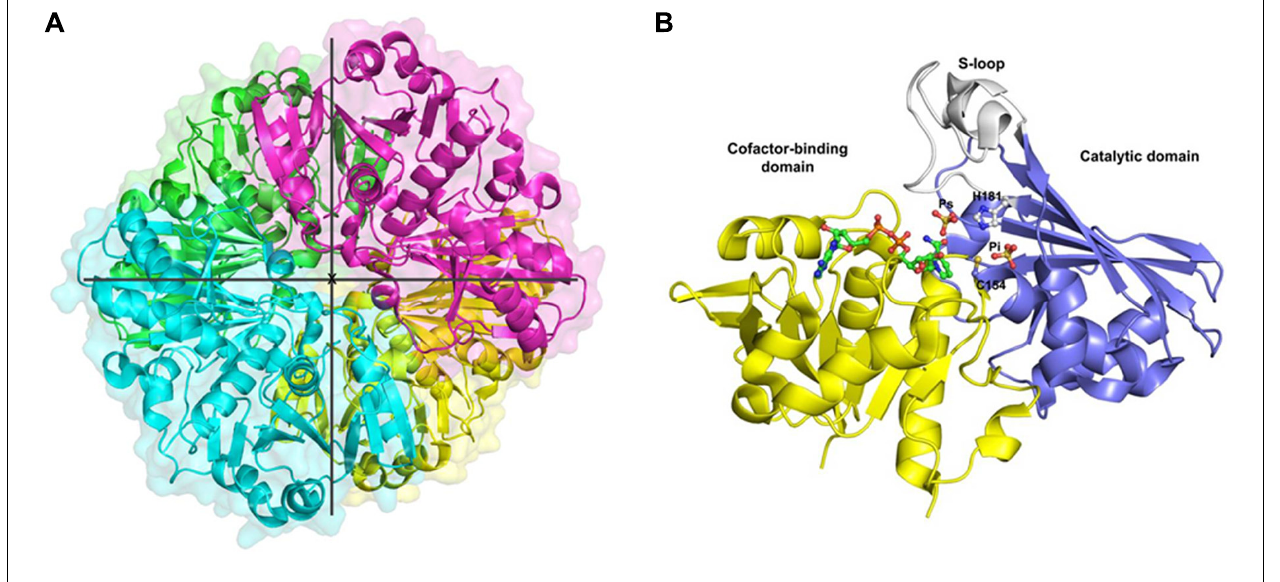
FIGURE 1 | Crystal structure of cytoplasmic GAPDH from rice. (A) Ribbon representation of the homotetramer of Oryza sativa (Os) GAPDH (PDB code 3E5R), each subunit is differently colored.The three symmetry molecular axes are represented (the x-axis is perpendicular to the plane). (B) Ribbon